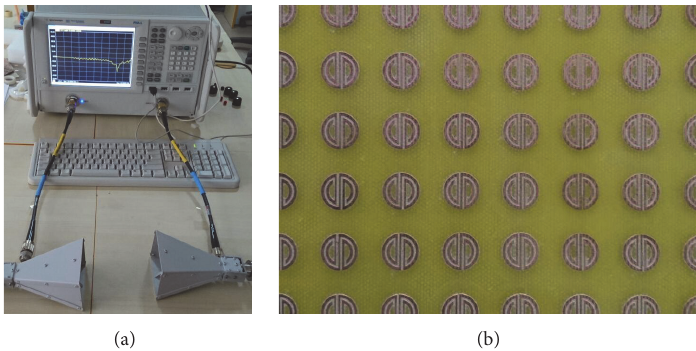
Figure 5: (a) Vector network analyzer, two horn antennas with coaxial cables. (b) Manufactured